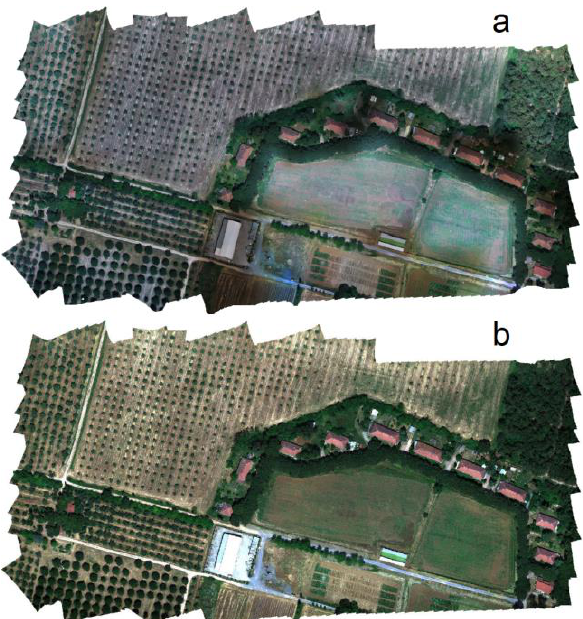
Figure 3. Generated orthomosaic: non-calibrated (a), calibrated (b)